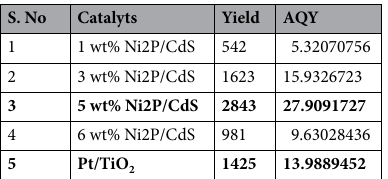
Table 1. Quantum yield obtained by catalysts 1–5. Bold is indicating present work which we are reporting in this manuscript, with significant